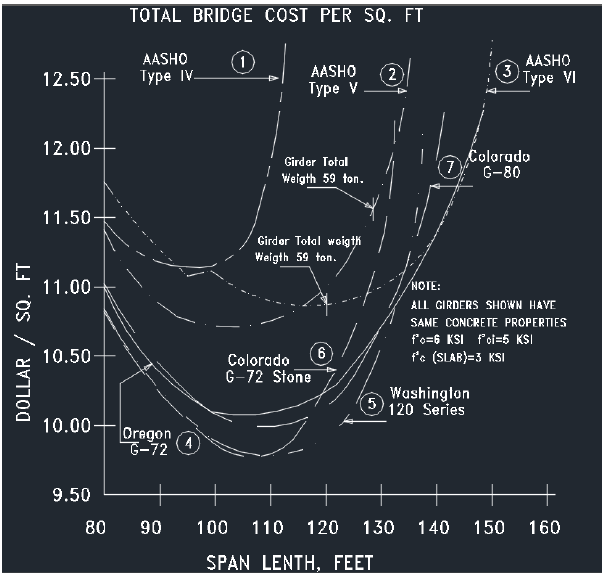
Figure 1. Optimum girder spacing cost curves for seven stone concrete